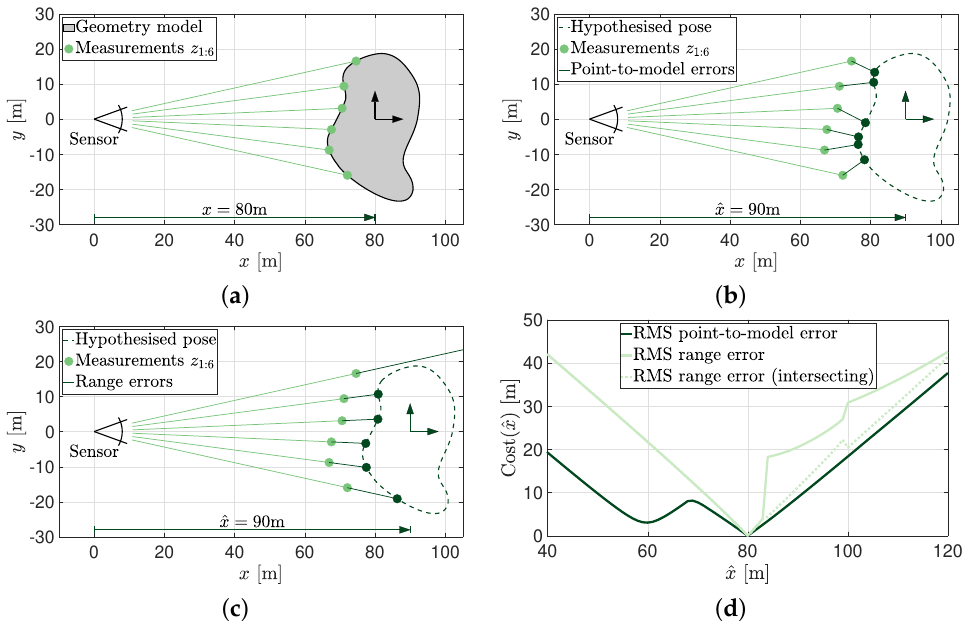
Figure 1. Cost-based metrics and their ability to provide for the estimation of object pose when provided with a perfect measurement set. ( a ) Six range measurements of a geometric body located at x = 80m. ( b ) Point-to-model errors when the geometry model is hypothesised to be located at ˆ x = 90m. ( c ) Range measurement errors when the geometry model is hypothesised to be located at ˆ x = 90m. ( d ) RMS point-to-model and range error cost metrics for hypotheses [ 40m ≤ ˆ x ≤ 120m ] . Equal arguments can be made for either removing or retaining the non-intersecting beam. Retaining the measurement will cause a discontinuity in the cost function as the RMS of range error will rise significantly when beams ‘fall off’ the model. Removing